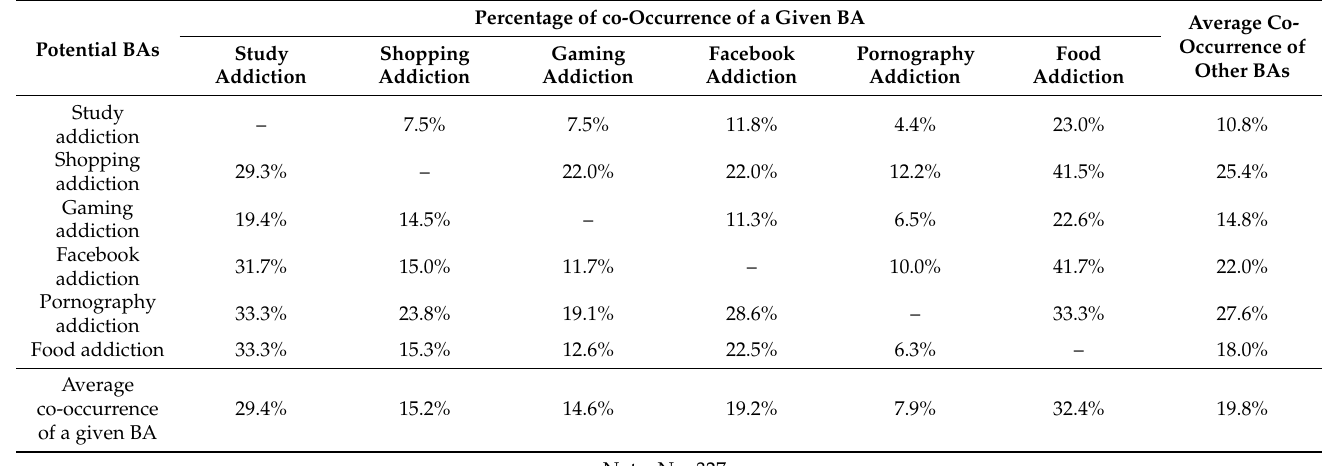
Table 5. Co-Occurrence of Potential BAs.